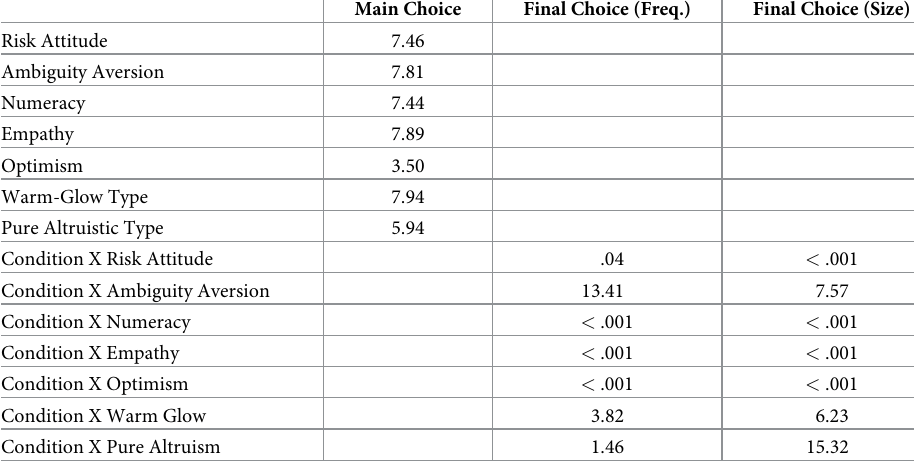
Table 7. Bayes factor model odds for null model. Main Choice Final Choice